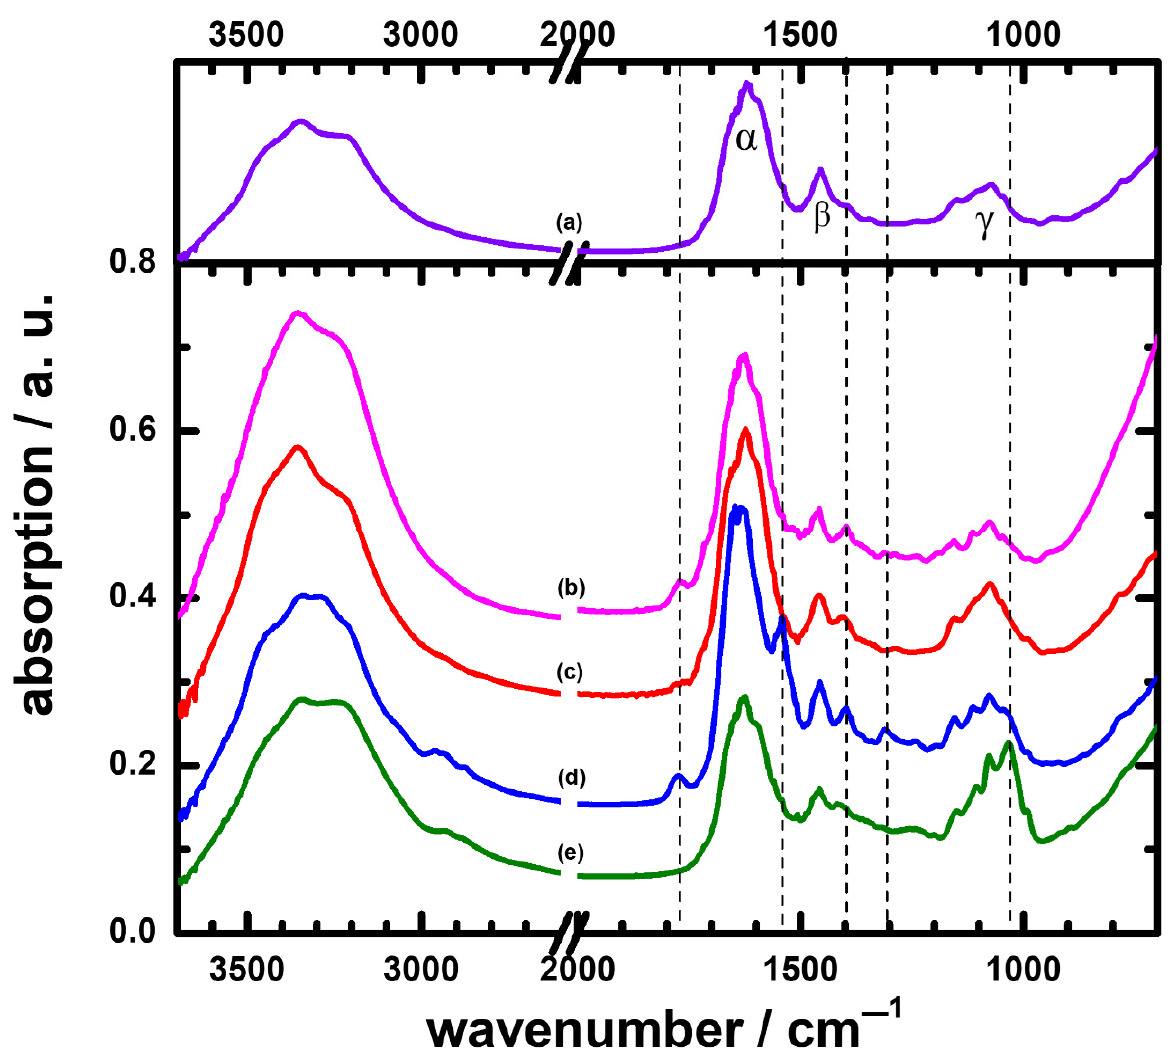
Figure 2. ATR-FTIR spectra of: ( a ) averaged 11 non-UTIs, designed as IR av/non ; and UTIs cultured by yeasts: ( b ) from patient No. 2; ( c ) from patient No. 3; ( d ) from patient No. 4; ( e ) from patient No. 6.